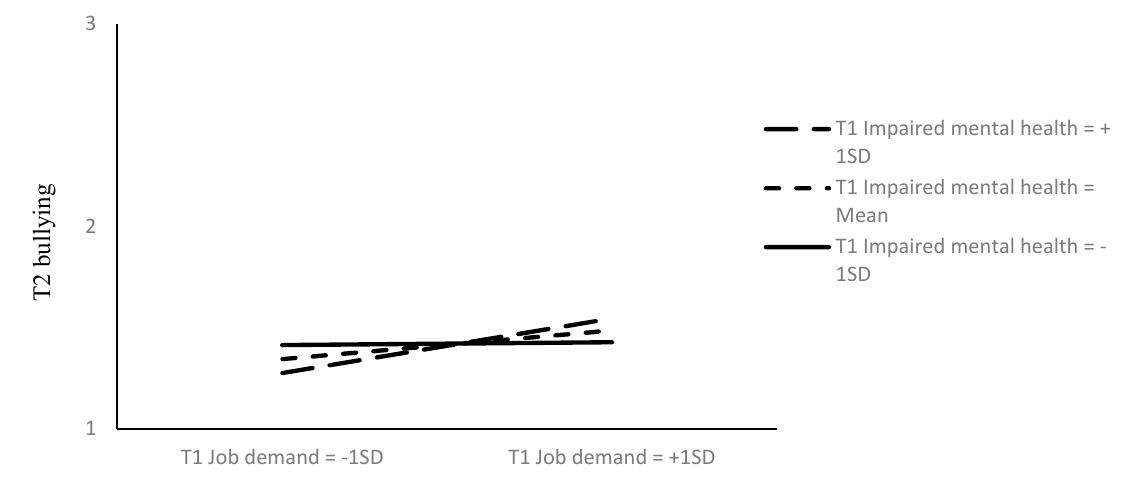
Figure 2. Path analytic model testing the interaction between T1 job demand and T1 impaired mental health (T1 JD X T1 IMH) on T2 bullying. Note. * p < 0.05. ** p < 0.01. *** p < 0.001.